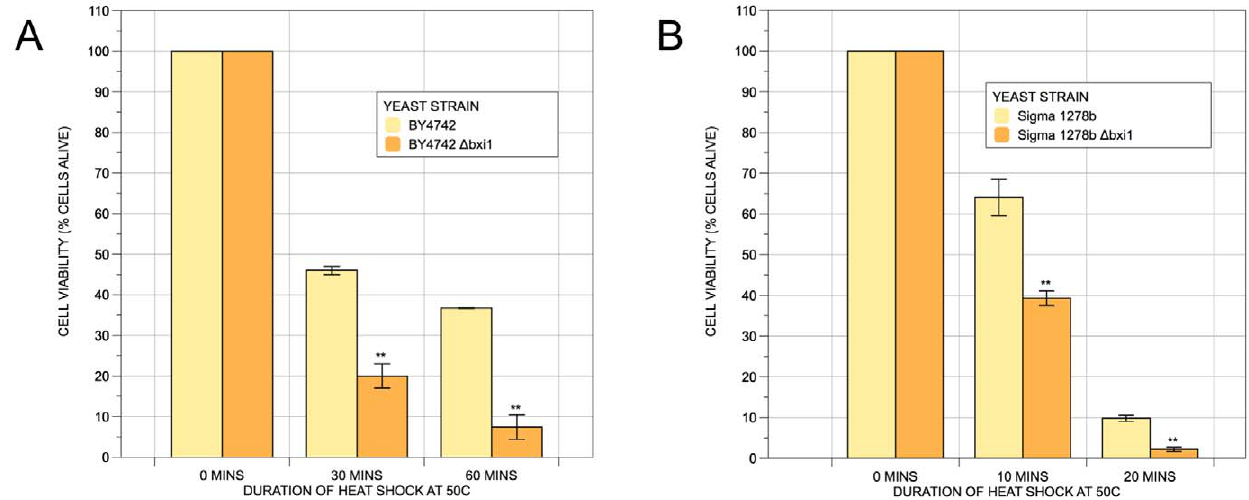
Figure 2. Yeast cells lacking BXI1 are sensitive to heat shock. Wildtype and D bxi1 cells from the BY4742 and S 1278b strain backgrounds were cultured in rich YPD media overnight. They were then resuspended in fresh media and allowed to reach exponential phase (an approximate OD 600 value of 0.4). Liquid cultures were then heat shocked at 50 u C in a water bath for the indicated times, serially diluted onto YPD plates, and cultured at 30 u C for 2 days. The difference in viabilities was deemed statistically significant by the Student’s t-test (p , 0.05). Error bars indicate standard deviations for trials with at least three independent cultures.